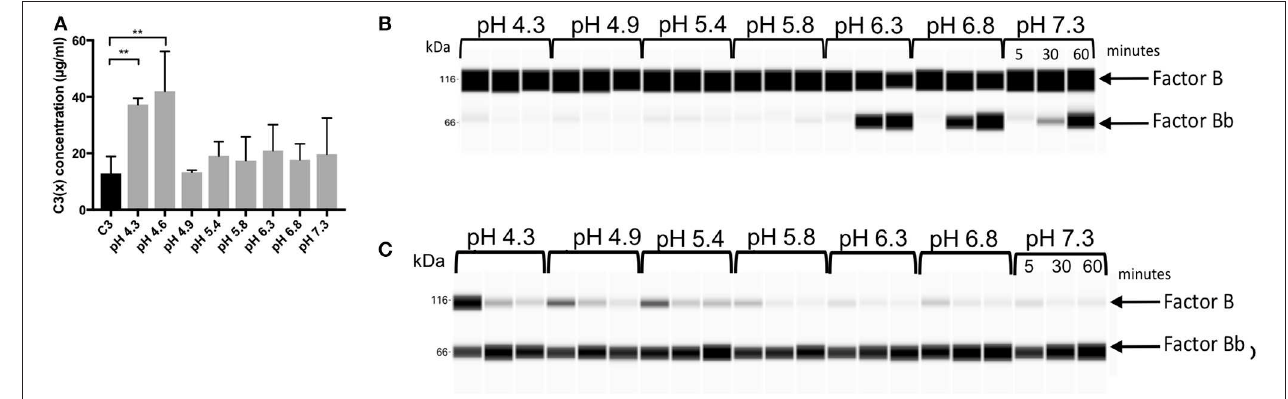
FIGURE 5 | (A) Measurement of C3(x) formation at different pH using the C3(x) ELISA. (B) Virtual blot view of Wes immunoassay analysis of Bb generation after addition of FD to C3 at different pH. (C) The corresponding virtual blots for Bb generation after addition of FD to C3 incubated at different pH, followed by re-neutralization back to neutral pH (7.4).